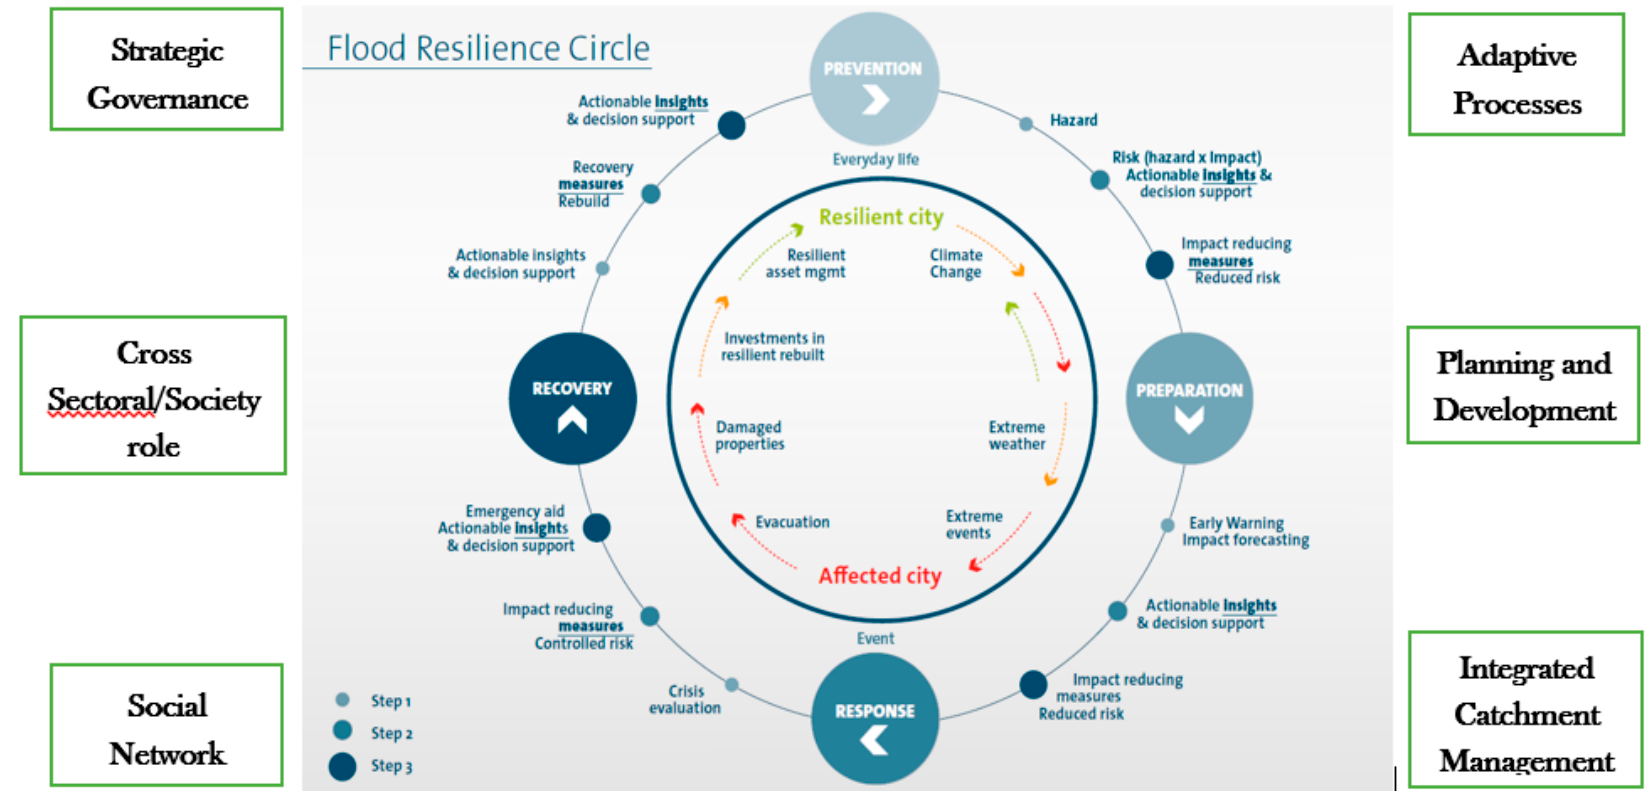
Figure 4. The flood resilience circle. (Adapted from Royal HaskoningDHV [45]).